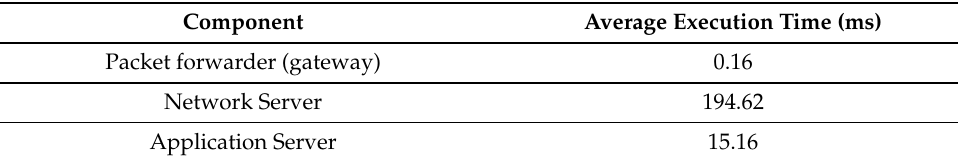
Table 1. Execution times of the components.